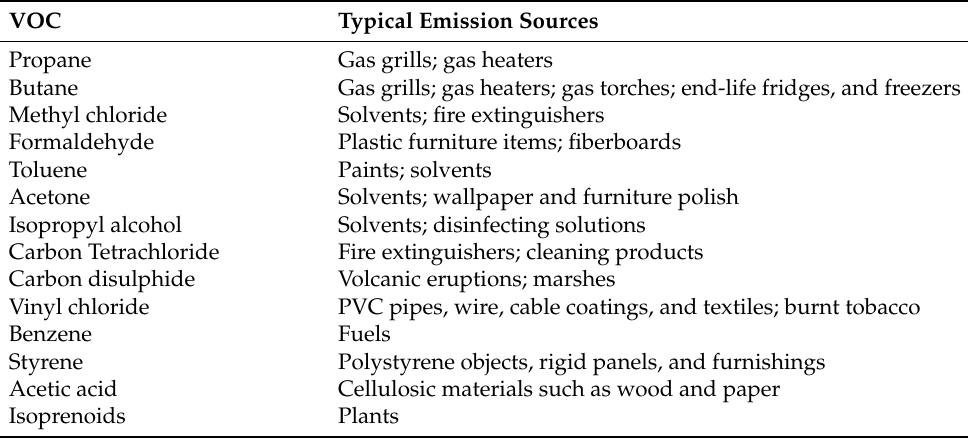
Table 1. Common VOCs and associated emission